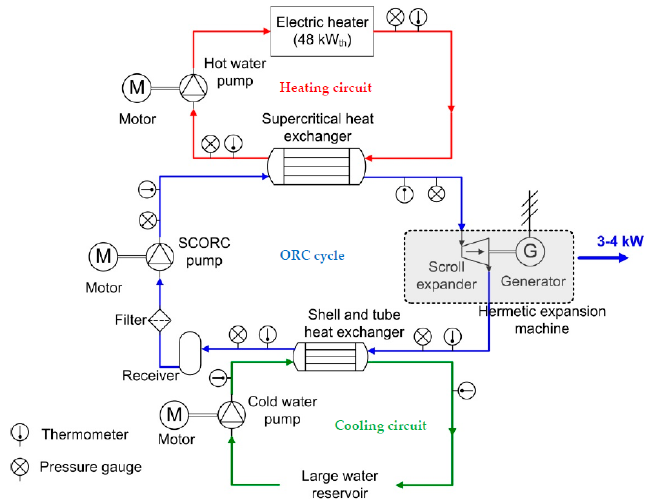
Figure 2. Simplified layout of the experimental concentrated photovoltaic/thermal (CPV/T)-organic Rankine cycle (ORC) test set-up (laboratory installation).